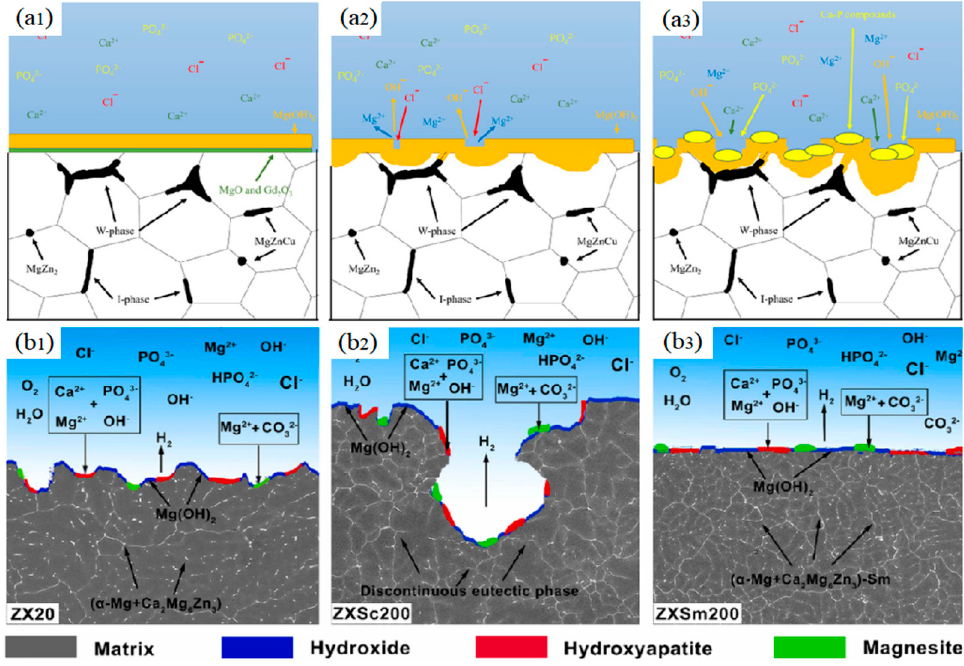
Figure 4. The corrosion mechanism of Mg − 2Zn − 1Gd − 0.5Zr − 0.1Cu alloy in Hanks’ solution: ( a1 ): Mg degradable and Mg(OH) 2 formation, ( a2 ): Mg(OH) 2 dissolution, ( a3 ) HA formation [52]; schematic illustration of corrosion mechanisms of the as − cast alloys immersion in Hanks’ solution: ( b1 ) Mg-2Zn-0.3Ca, ( b2 ) Mg-2Zn-0.3Ca-0.4Sc, ( b3 ): Mg-2Zn-0.3Ca-0.4Sm [59]. Reprinted with permission from refs. [52,59]. Copyright 2022 Elsevier.